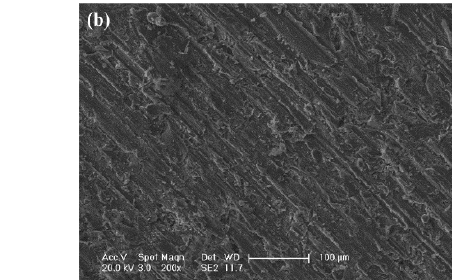
Figure 11. ( a ) Microhardness distribution curves of different layers with standard error bars. ( b ) Average hardness and wear loss of different layers.